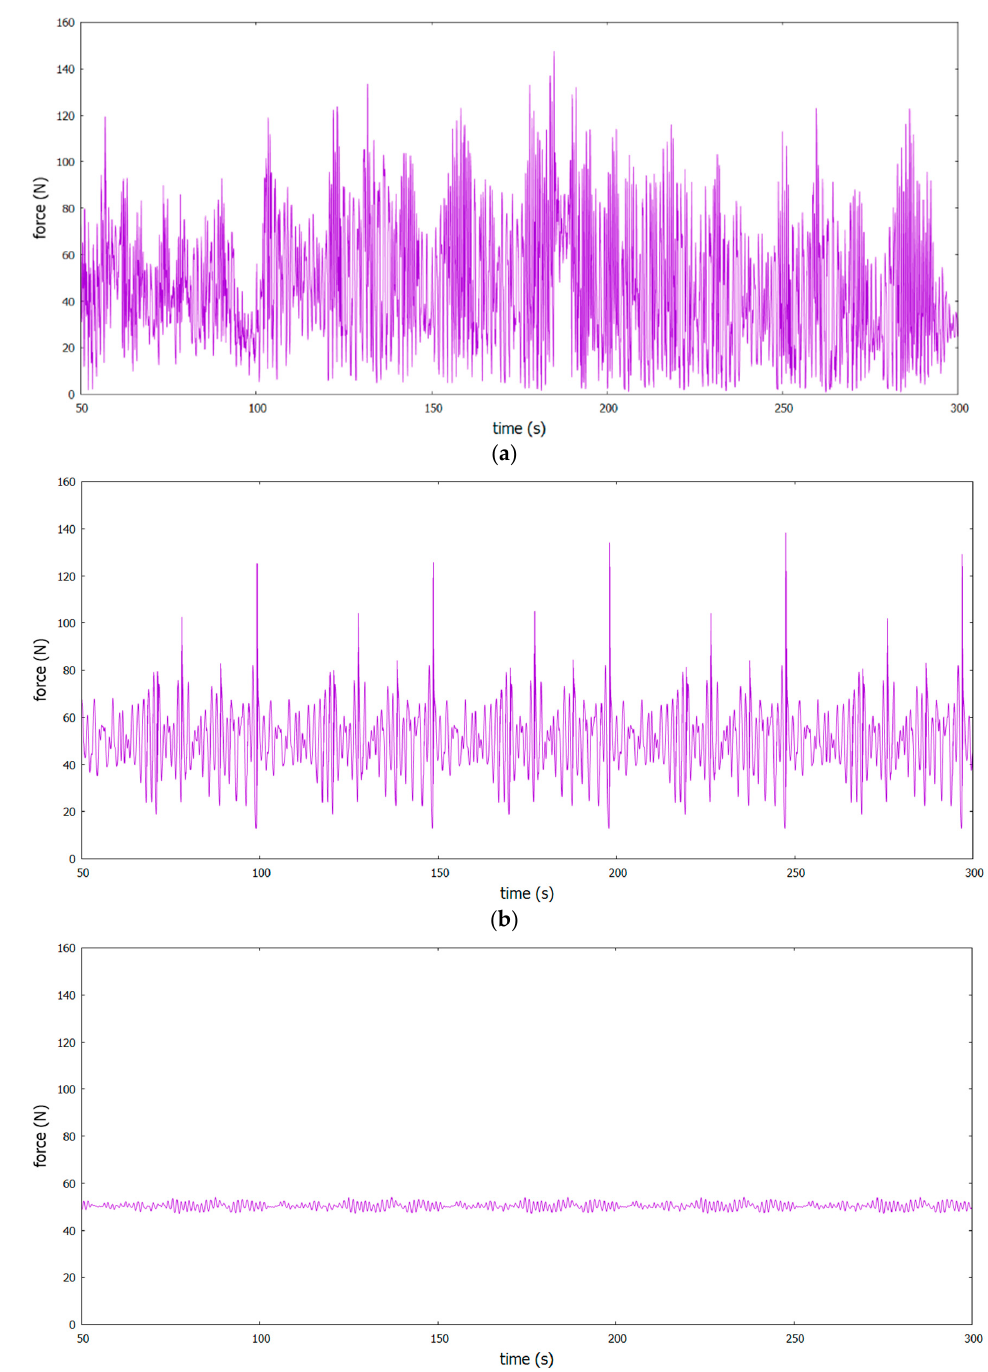
Figure 19. ( a ) Time series of mooring tension in experiments with buoy and inextensible cables (A) with T p = 1.4 s for H s = 0.13 m. ( b ) Time series of mooring tension from model with buoy and inextensible cables (A) with T p = 1.4 s for H s = 0.13 m. ( c ) Time series of mooring tension from model with elastic cables to buoy and float (D) with T p = 1.4 s for H s = 0.13